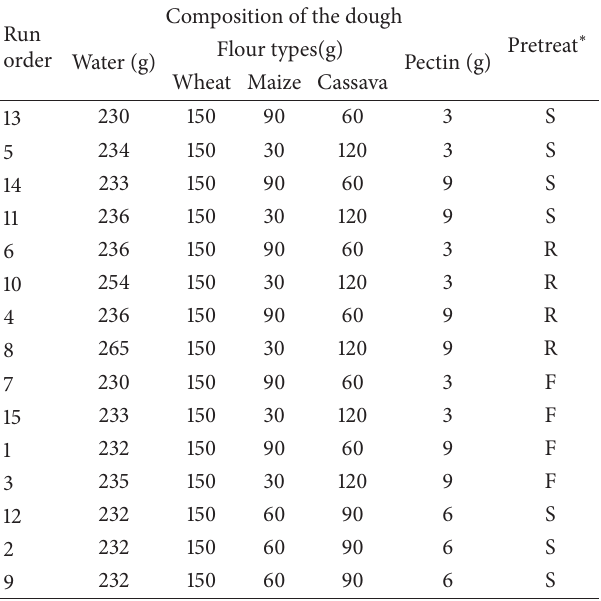
Table 1: Dough formulae of bread samples in the experimental